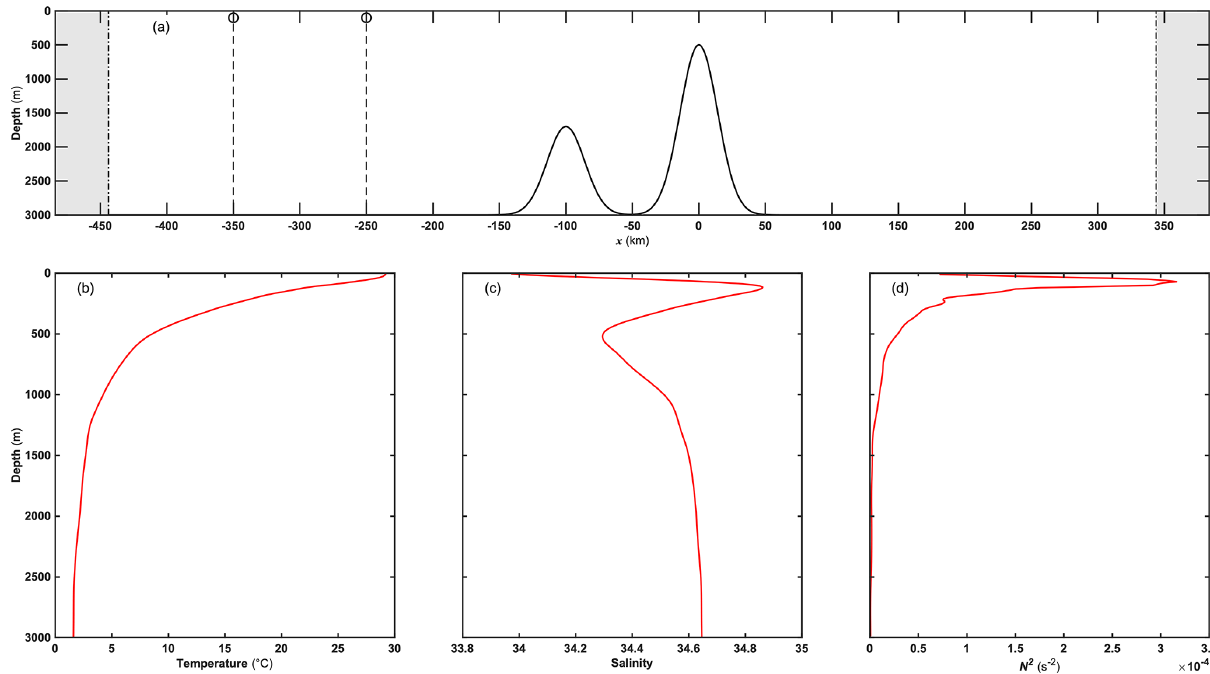
Figure 17. (a) A sketch of generated NIWs over the submerged double-ridge system case; the gray zones indicate the sponge layers. The summer stratification in 2011 including (b) temperature, (c) salinity, and (d) buoyancy frequency squared is from the spatial mean within